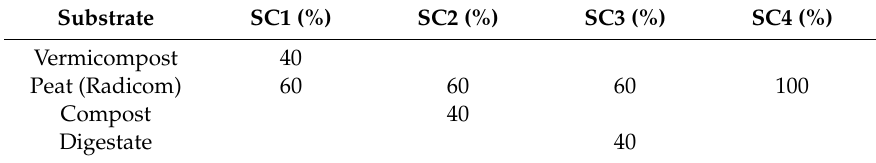
Table 1. Four Substrate Compositions (SC) (%) used for growing the sage plants.